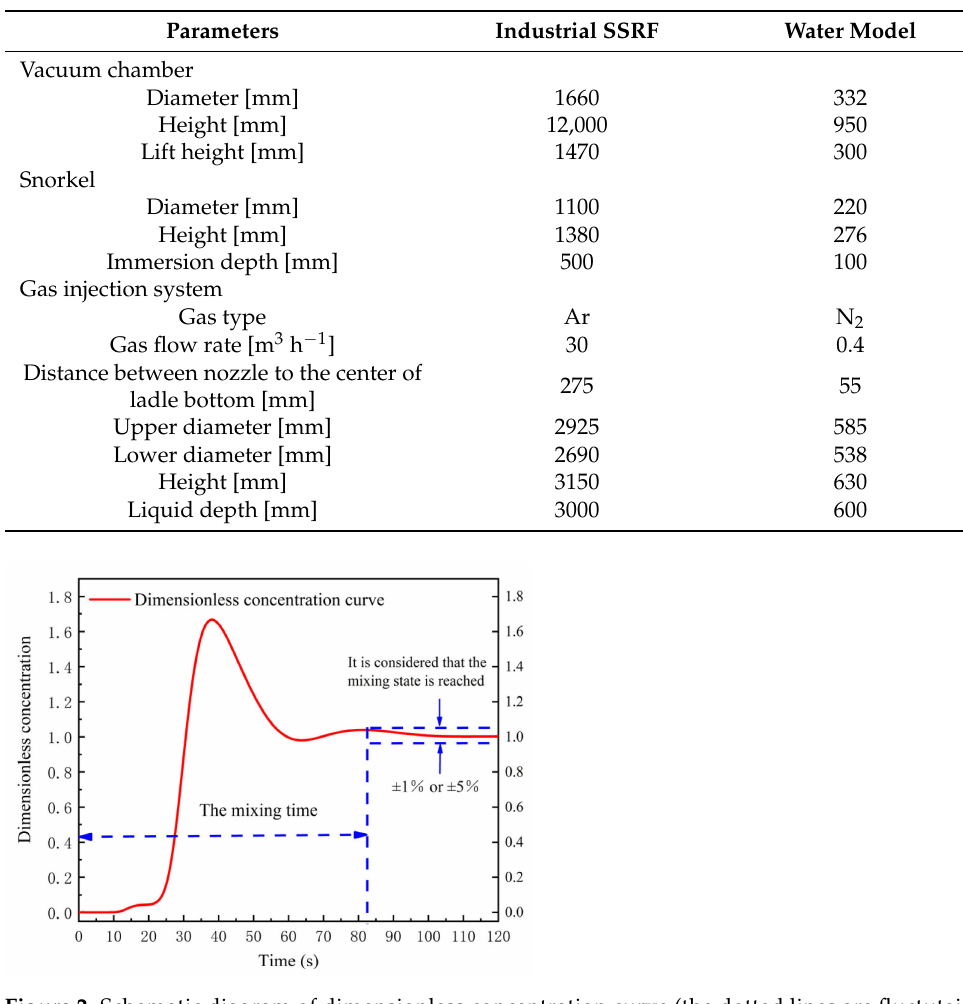
Figure 2. Schematic diagram of dimensionless concentration curve (the dotted lines are fluctutaion range and mixing time).